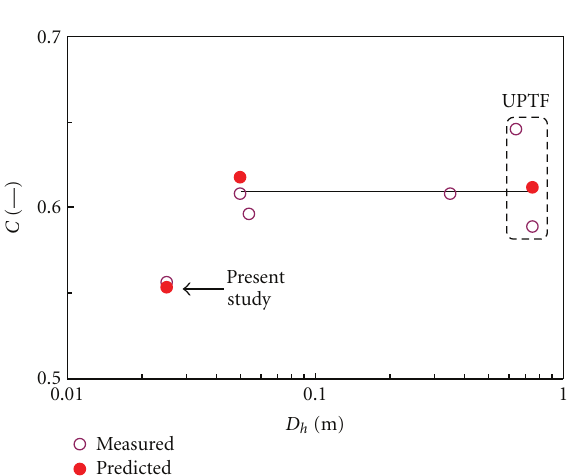
Figure 6: CCFL constants arranged by hydraulic diameters.